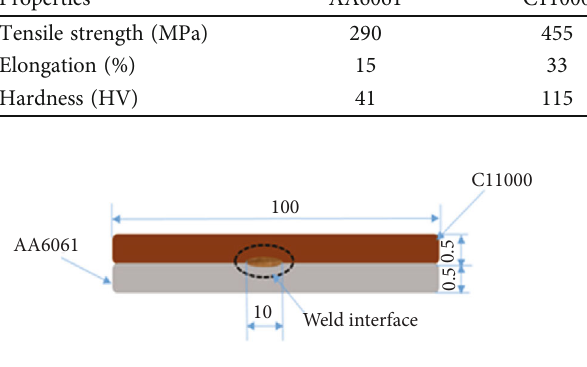
Figure 2: Workpiece dimensions for